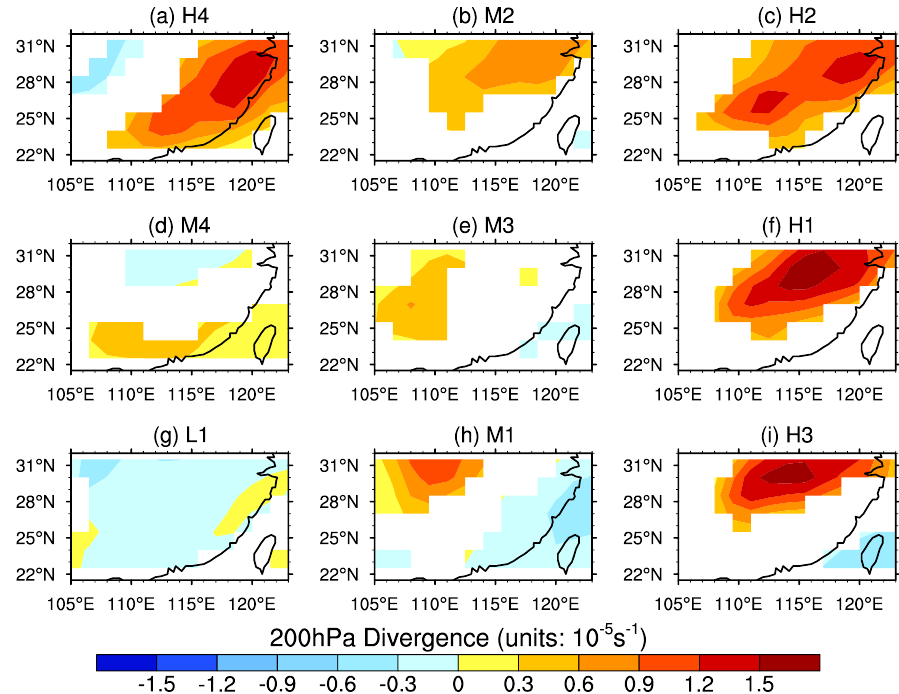
Figure 6. ( a – i ) Composite means of divergence (units: 10 − 5 s − 1 ) at 200hPa for the nine regimes during AMJ 1979–2015. Only composite means that pass the 95% confidence level based on two-sided Student’s t test against the complementary set of samples are